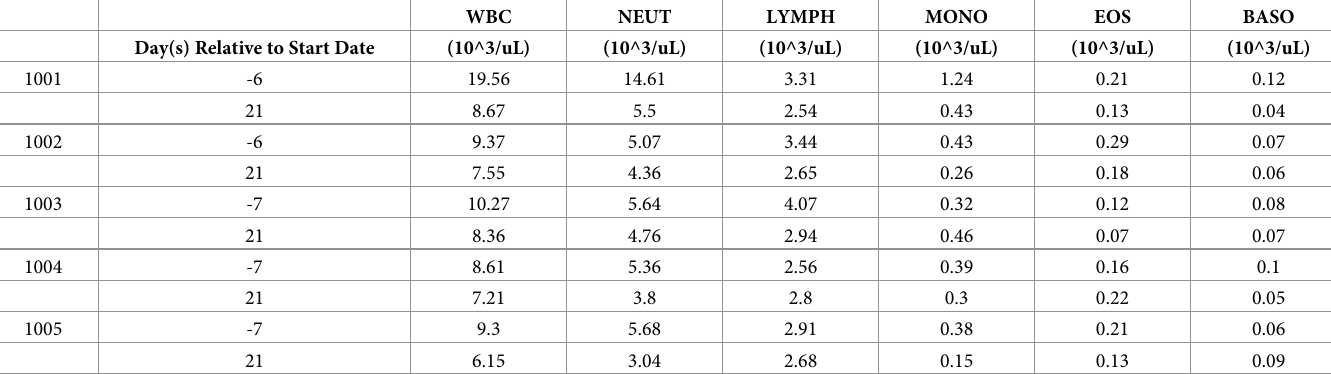
Table 1. Hematology reporting for each animal for WBC, NEUT, LYMPH, MONO, EOS, and BASO.